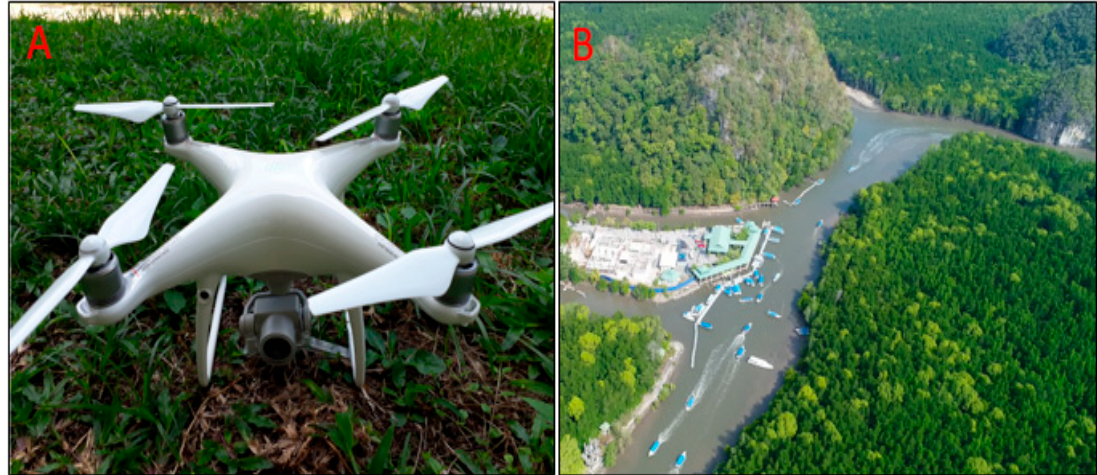
Figure 2. ( A ) The DJI Phantom 4 model used in this study; ( B ) An aerial view of study area captured by unmanned aerial vehicle (UAV).